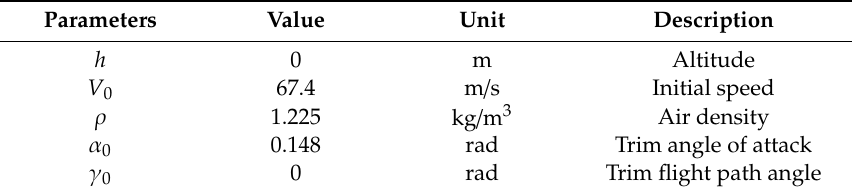
Table 2. The trim